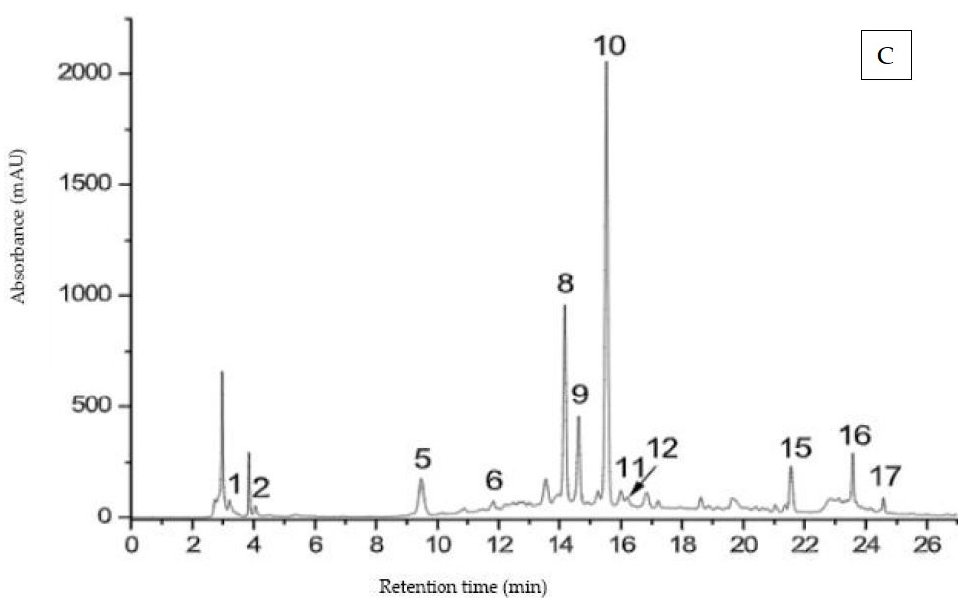
Figure 3. HPLC chromatogram of phenolic compounds in buckwheat achenes ( A ), buckwheat sprouted for 3 days ( B ) and buckwheat sprouted for 7 days ( C ). 1—Hydroxyseisocolariciresinol; 2—Epigallocatechin (EGC); 3—Epigallocatechingallat (EGCG); 4—Gallocatechingallate (GCG); 5—Coumestrol; 6—Catechin; 7—Secoisolariciresinol; 8—Orientin; 9—